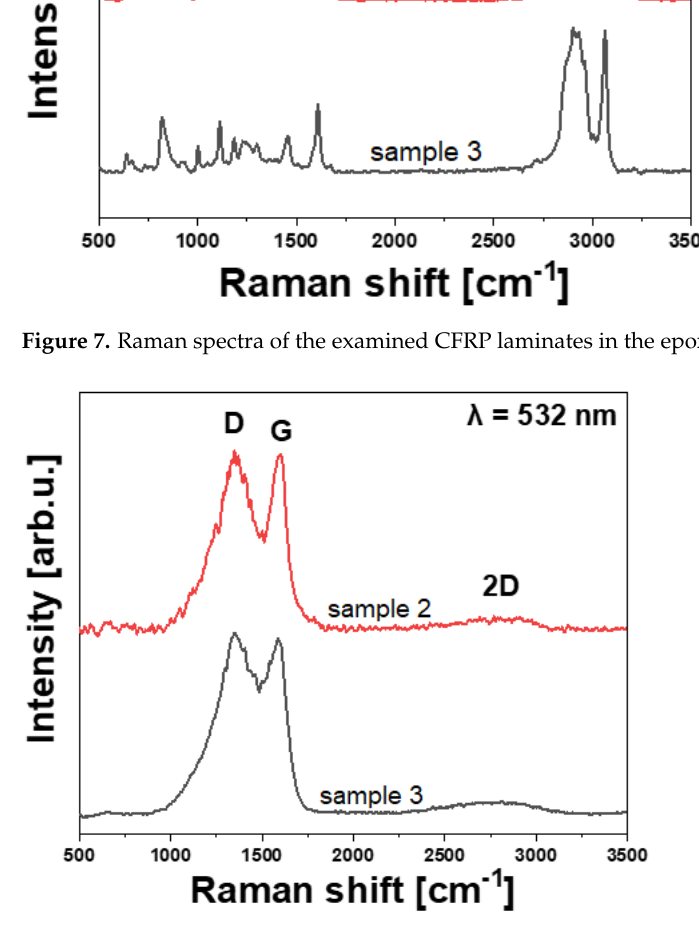
Figure 8. Raman spectra of the examined CFRP laminates in the carbon fibers regions. Table 3. IR absorption bands of the examined CFRP laminates .